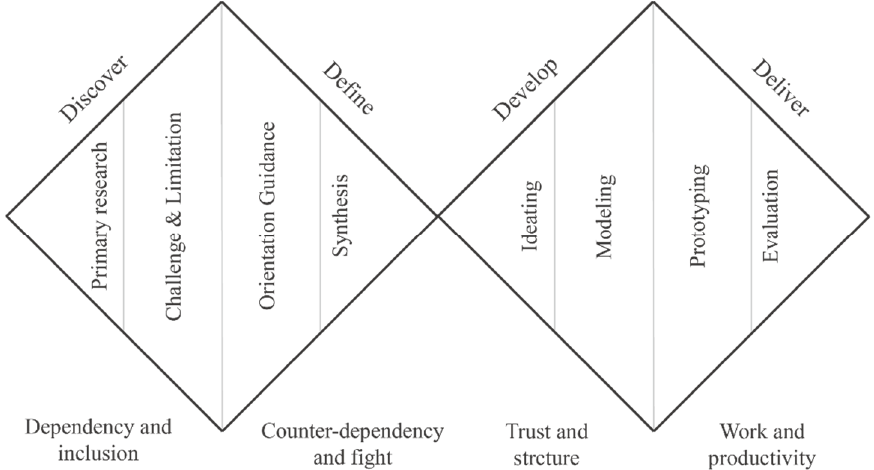
Figure 2. The four-stage double-diamond design model.